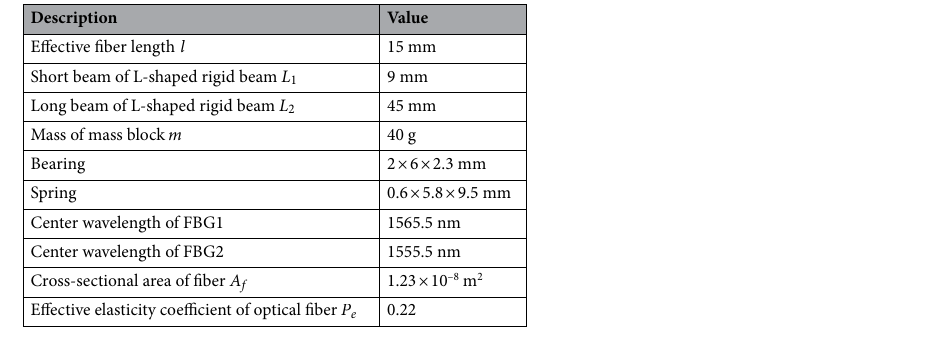
Table 2. Structural parameters of the